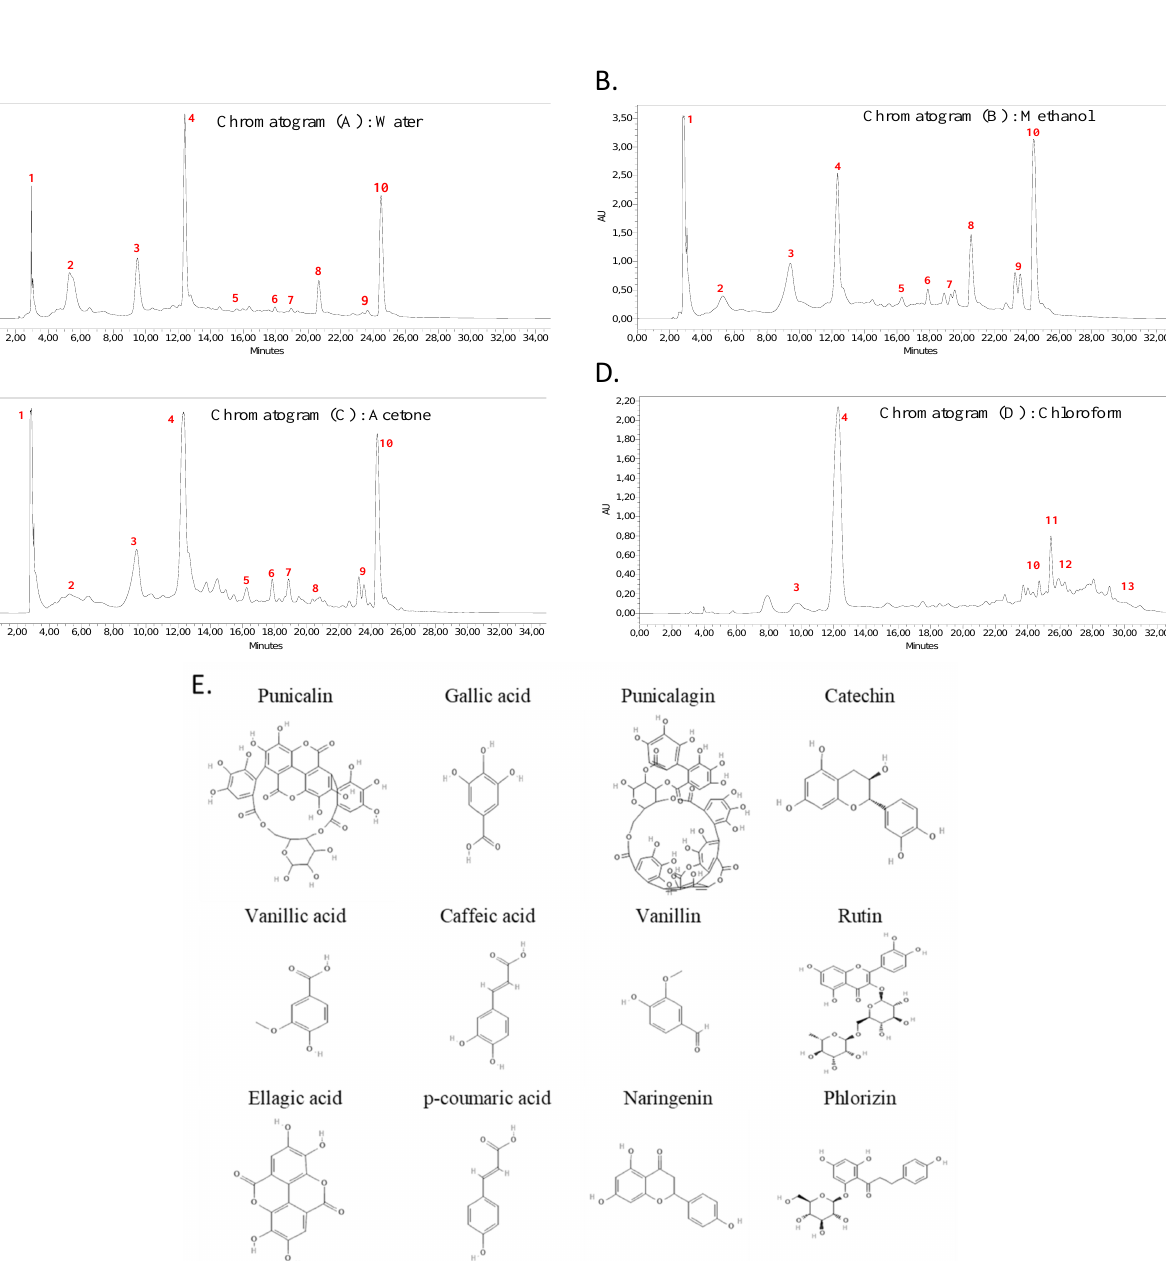
115.89 ± 3.04 b GAE: gallic acid equivalent; QE: quercetin equivalent; DW: dried weight. Different superscript let- ters indicate significant differences at p < 0.05. 3.4. HPLC-DAD Phytochemical Characterization First, GC-MS confirmed the fatty acid composition of the defatted hexane fraction (HEE) of the pomegranate bark (Figure S1; Table S1). These results are in good agreement with previous reports [35 – 37] and show the effective elimination of the majority of the fatty acid fraction using hexane. The chemical composition for each extract obtained with different solvents (water, methanol, acetone, and chloroform) was determined by HPLC-DAD. The identification was carried out by comparison with the standard molecules using our internal database (Figures 2 and 3); consequently, the majority of the peaks were assigned. It clearly appears that the shape and intensity of the chromatogram acetone signals were much closer to those of methanol than those of water. This is endorsed by the close amounts of (TPC) and (TFC) found on the quantitative phytochemical analysis (Table 2). Data analysis showed the presence of various compounds which distributed into dif- ferent extracts: flavonoids (rutin, naringenin, catechin,) phenolic acids (ellagic acid, gallic acid caffeic acid, p -coumaric acid, vanillic acid), and ellagitannin (punicalin and puni- calagin isomers). It should be noted that several compounds had similar molecular struc- tures. Others may have resulted from a sample degradation reaction (Figure 4).